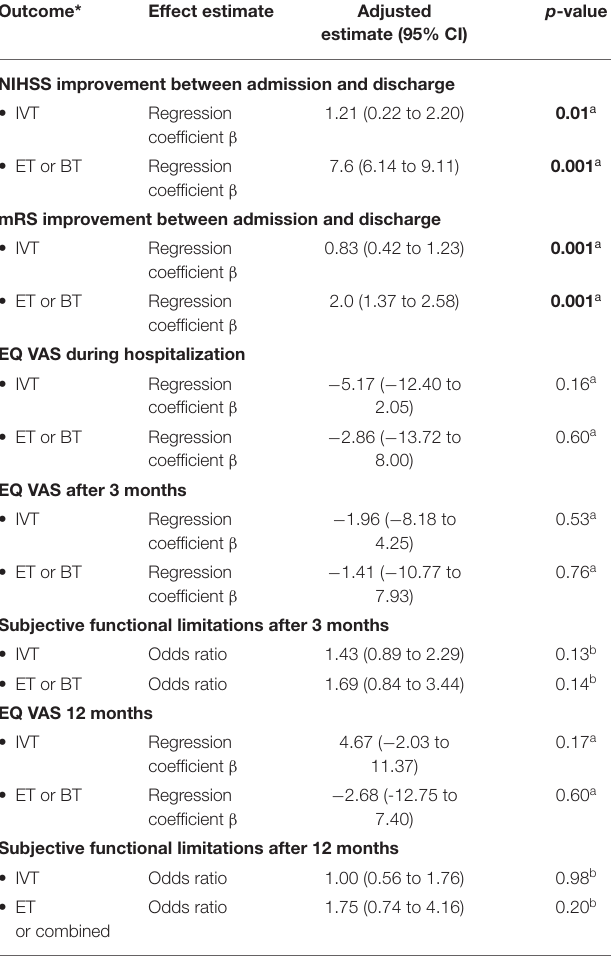
TABLE 3 | Follow-up after 3 and 12 months of stroke patients with and without recanalization therapy [thrombolysis (IVT), endovascular therapy (ET) or bridging therapy